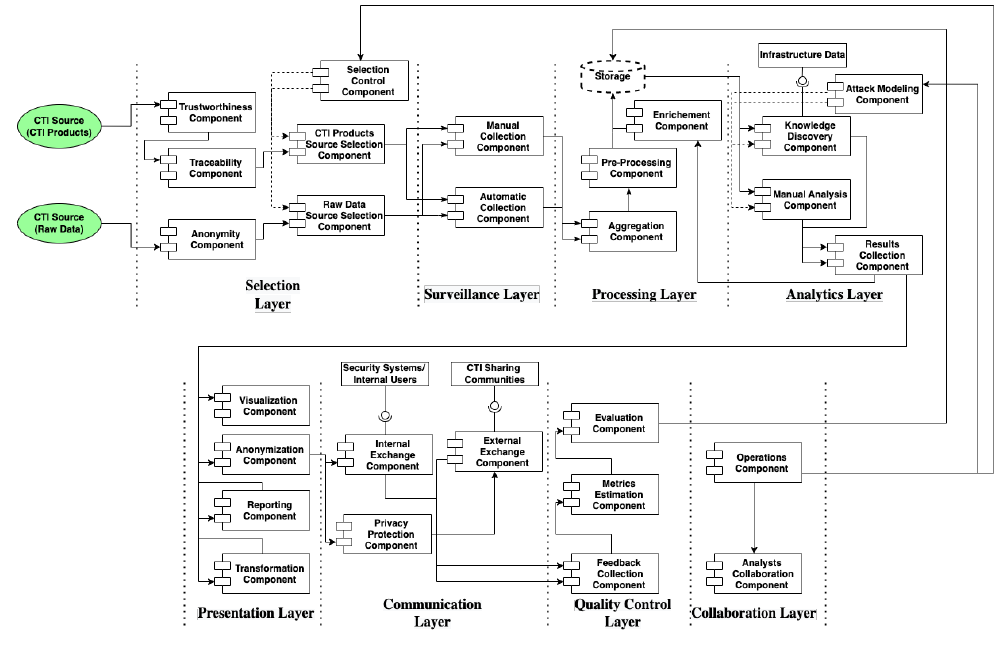
Figure 14. CTI Reference Architecture of Case Study